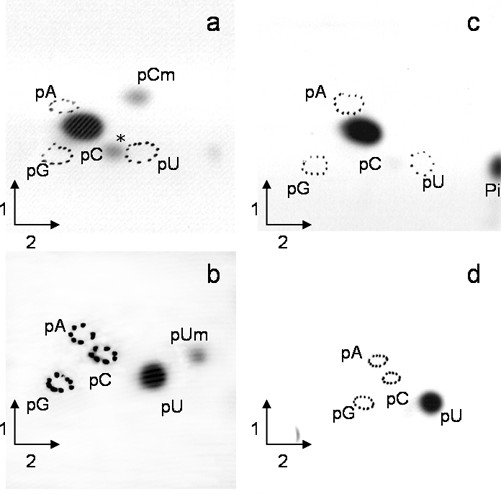
Nuclease P1 cleavage of in vitro transcribed E. coli tRNASer1 and tRNAGln2 incubated with YfhQ and AdoMet. Autoradiography of two-dimensional chromatograms of 5'-phosphate and 3'-phosphate nucleosides on thin layer cellulose plates. [α-32P]CTP-labelled in vitro transcribed tRNASer1 (2.5 × 105 cpm) (a and c) and [α-32P]UTP-labelled in vitro transcribed tRNAGln2 (2.5 × 105 cpm) (b and d) was incubated in the presence (a and b) or absence (c and d) of the YfhQ protein. The reaction mixture contained 50 mM PIPES-Na, pH 7.0, 4 mM MgCl2, 50 μM AdoMet and 5 μg of the purified YfhQ protein. After 90 min incubation at 37°C, the tRNA was recovered, cleaved by nuclease P1, the resulting nucleotides were analyzed as described [34]. The additional spot marked with an asterisk ("*") corresponds to an unknown species, a product either of an unusual cleavage pattern modified by the presence of 2'-O-methylation or degradation.